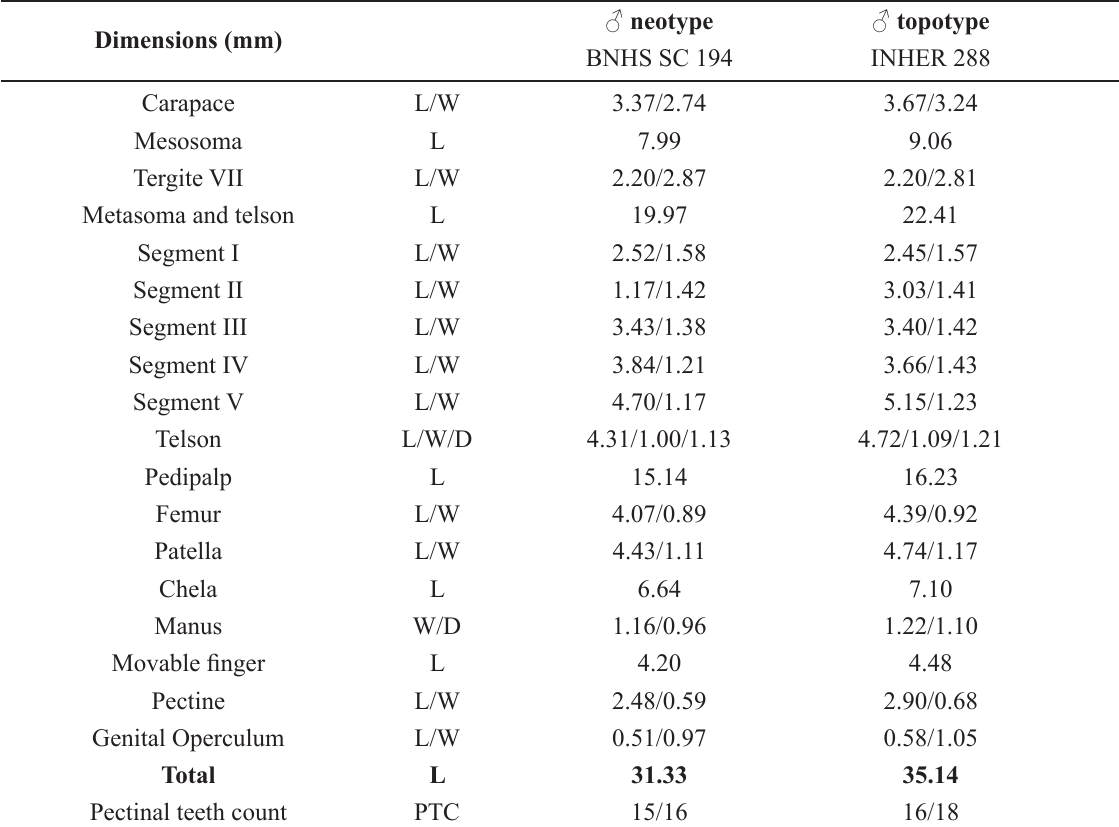
Table 1. Morphometric data for Isometrus sankeriensis Tikader & Bastawade, 1983 . Abbreviations: L = length; W = width (in carapace corresponding to median width); D =